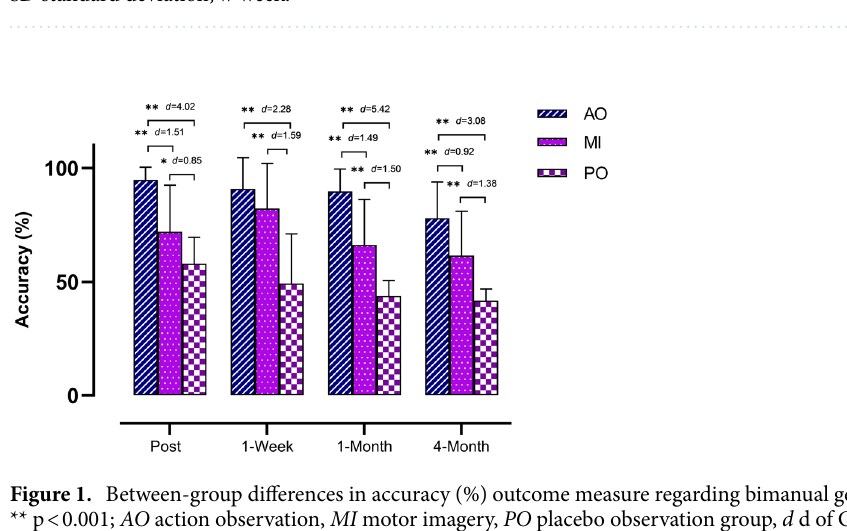
Table 2. Intragroup differences in the accuracy (%) outcome measure. *p < 0.05; **p < 0.001. AO action observation group, CI confidence interval, m month, MI motor imagery group, PO placebo observation group, SD standard deviation, w week.